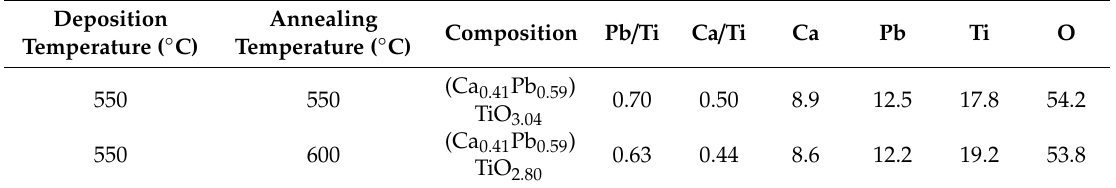
Table 1. EDS results for calcium modified lead titanate (PCT) film deposited at 550 ◦